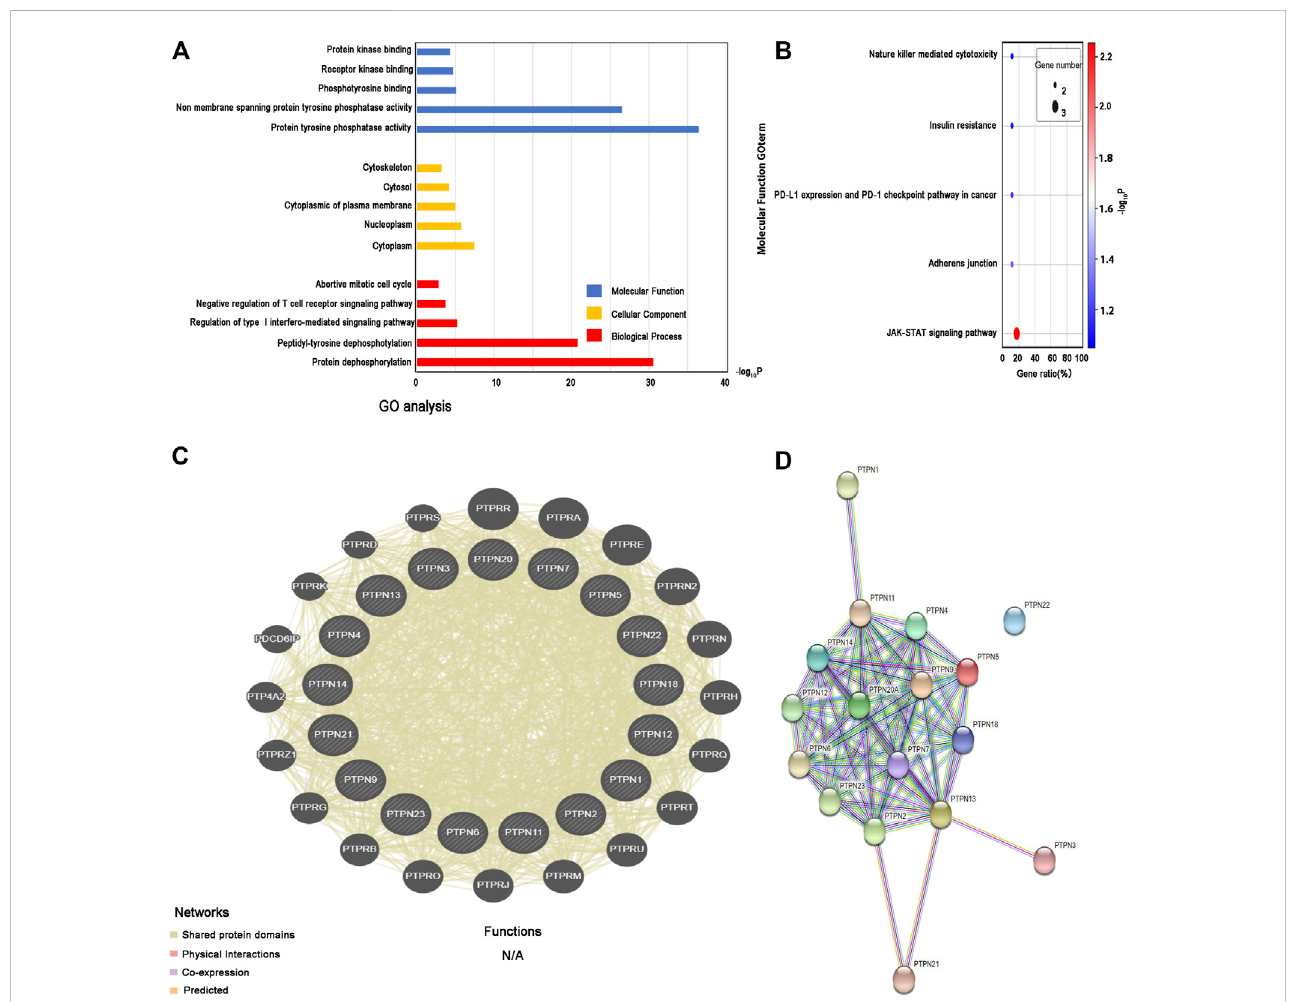
FIGURE 7 Enrichment and correlation analysis among PTPN family genes. (A) GO analysis of PTPN family genes. The top fi ve enriched categories for Molecular Function, Cellular Component, and Biological Process were showed. (B) KEGG pathway analysis of PTPN family genes, top fi ve KEGG pathway category were showed. (C) Gene – gene interaction network among PTPN gene family members. (D) Protein – protein interaction network among PTPN gene family